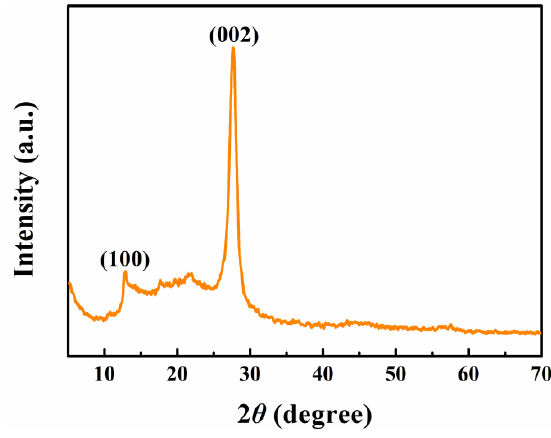
Figure 2. XRD patterns of g-C 3 N 4 .